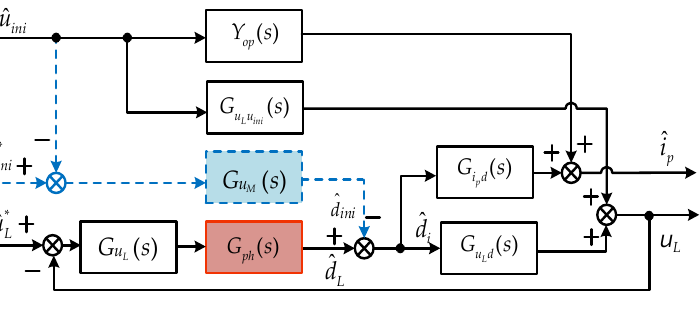
Figure 10. Small-signal block diagram of DAB with G ph ( s ) .